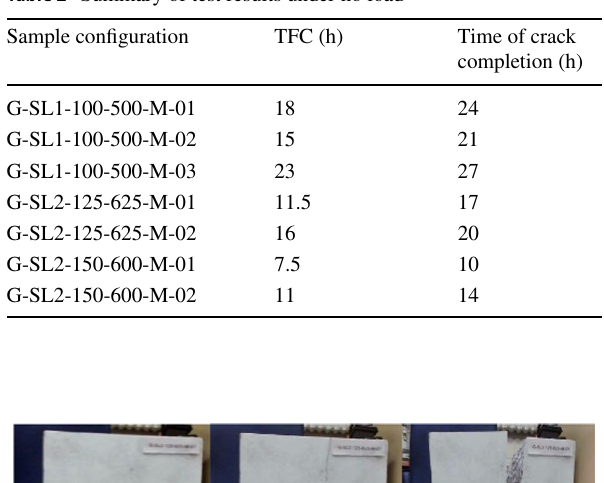
Table 2 Summary of test results under no load Sample configuration